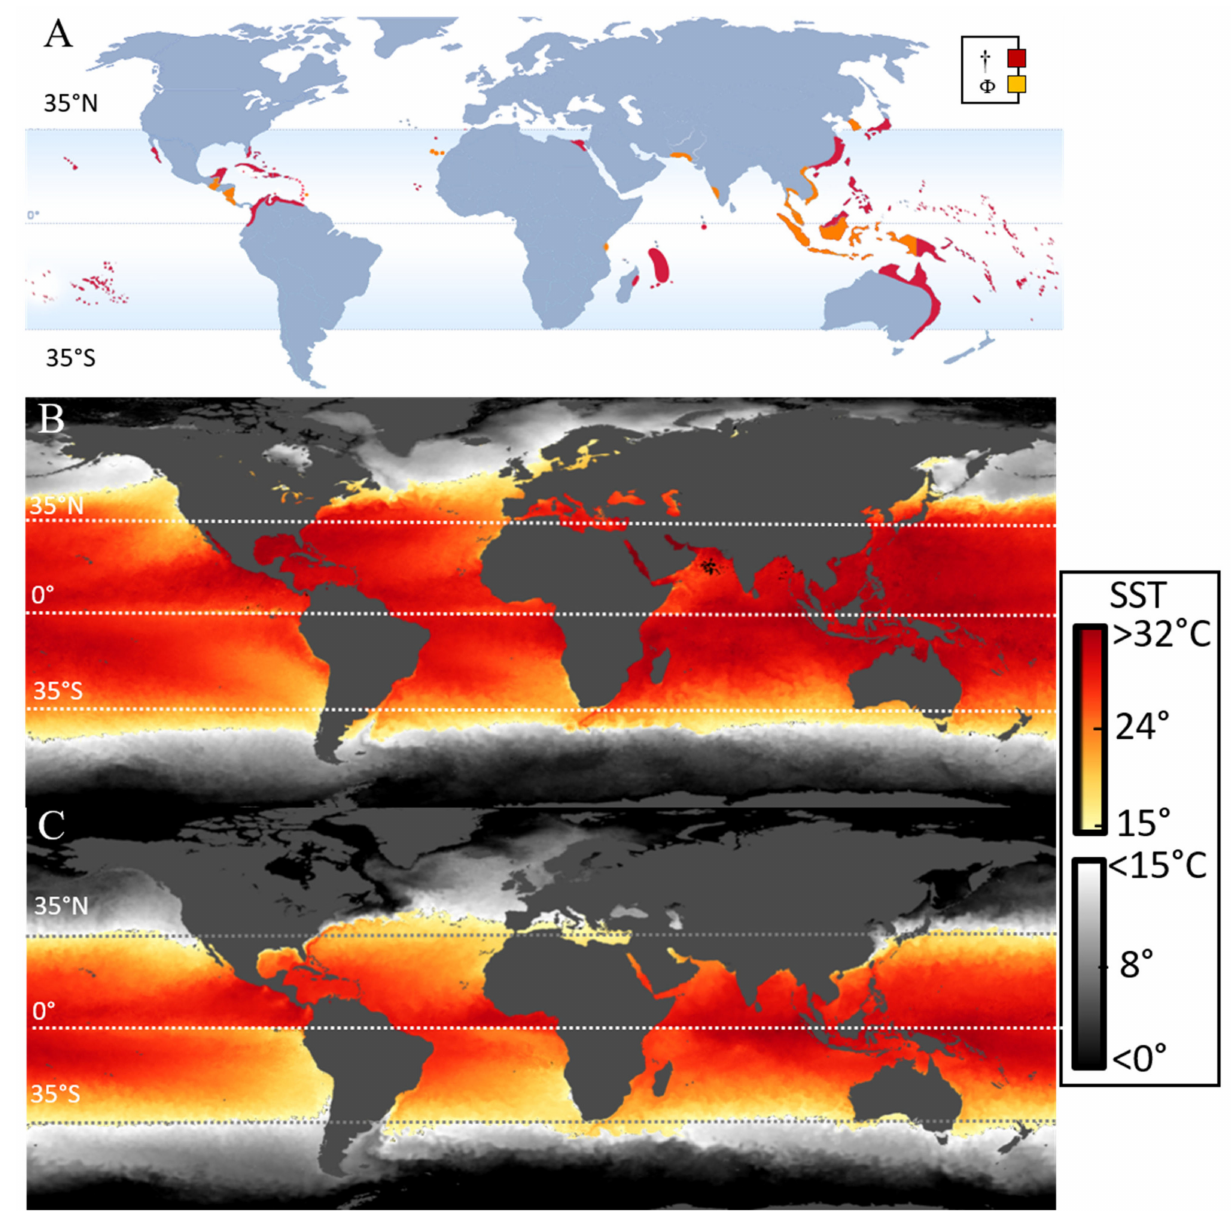
Figure 2. Global map of endemic areas for ciguatera poisoning and satellite-derived sea surface temperatures (SST) divided into two scales, <15 ◦ C and ≥ 15 ◦ C. ( A ) map from https://www.ciguatera.pf/index.php/en/la-ciguatera/ciguatera- distribution (accessed on 15 March 2021) and (reproduced with permission from © Louis Malard é Institute 2020) showing † areas with indigenous ciguatera cases reported and φ areas with indigenous ciguatera cases reported since 2000. ( B ) Satellite- derived average SST for the most recent peak month of summer in the northern (projection: https://go.nasa.gov/3m1rVhW (accessed on 15 March 2021)) and southern (projection: https://go.nasa.gov/35X8Vvp (accessed on 15 March 2021)) hemisphere, combined. ( C ) Satellite-derived average SST for the most recent peak month of winter in the northern (February 2020) and southern (August 2020) hemisphere, combined. Gray scale temperature map encompasses the temperatures <15 ◦ C. Red scale color palette is from 15 to ≥ 32 ◦ C. Satellite SST data generated from the NASA Worldview National Atmospheric and Space Agency’s EOSDIS Worldview app, version 3.8.2. Geostationary imagery layers generated from the following sources